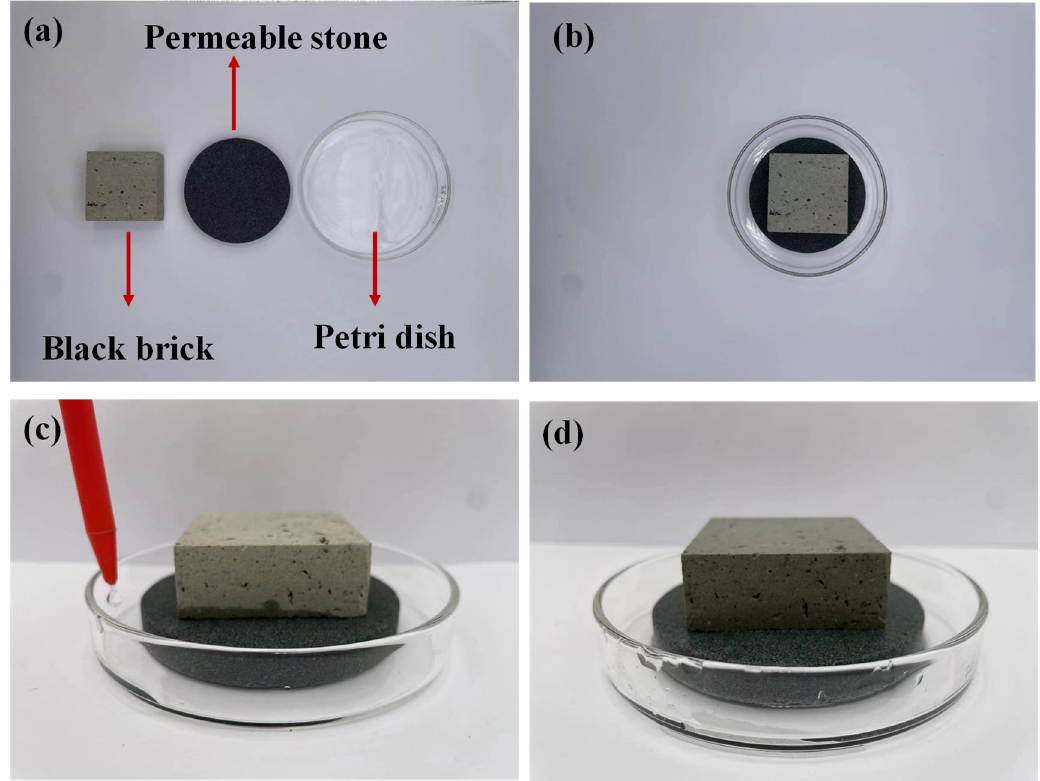
Figure 4. ( a ) Black bricks, permeable stones, and Petri dishes. ( b ) The permeable stone was placed in the Petri dish, and the black brick was placed on the pervious stone. ( c ) Ten milliliters of 5% sodium sulfate solution was dropped into the Petri dish. ( d ) After standing for 30 min, water and salt were transported to the brick by capillary action of the permeable stone.